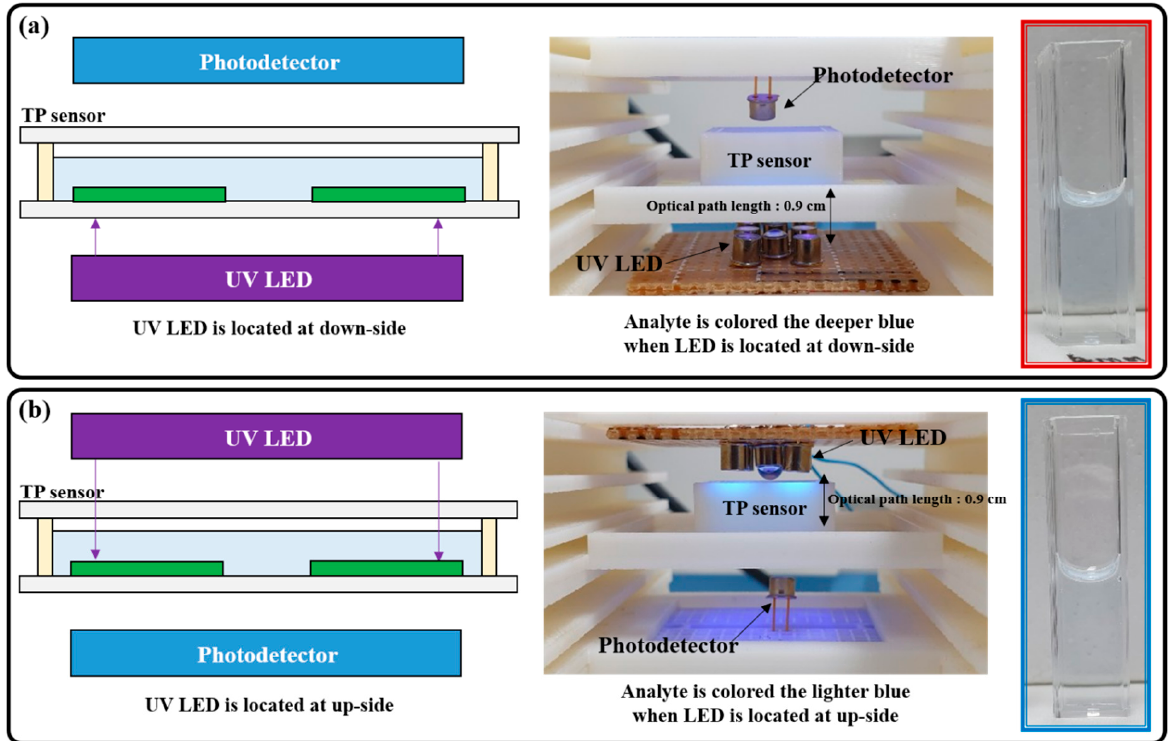
Figure 10. Schematic of the experimental setup and picture of the colored analytes along the UV LED locations: ( a ) down and ( b ) up sides.